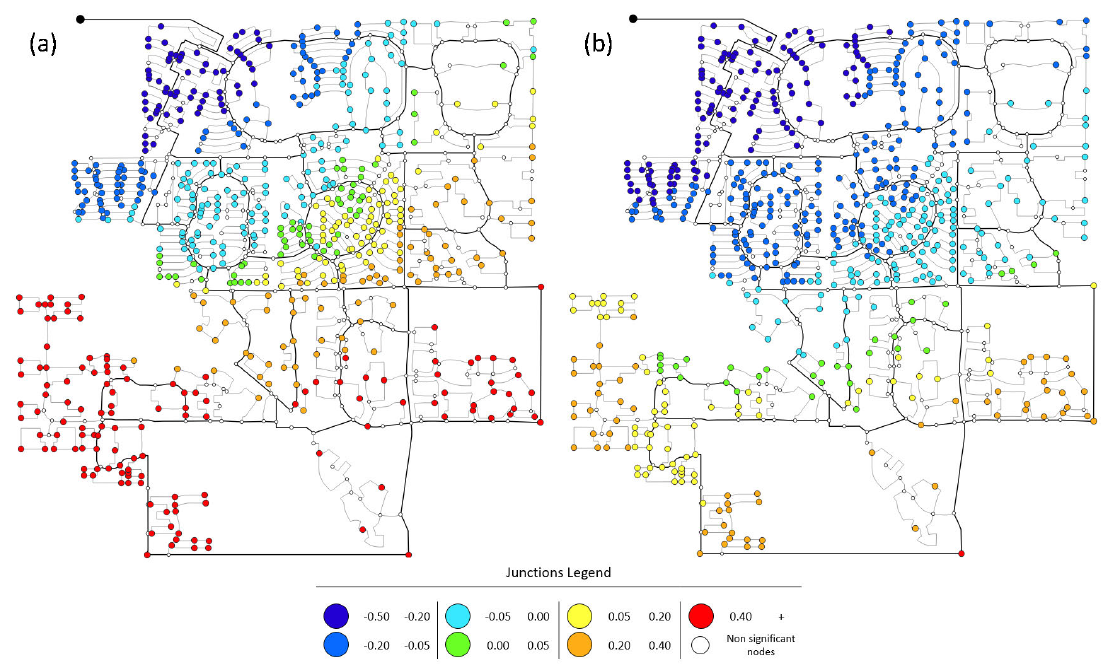
Figure 9. Graphs containing the local pressure head surplus index, for a peak coefficient P c = 2.5. ( a ) DDA simulation result. ( b ) PDA simulation